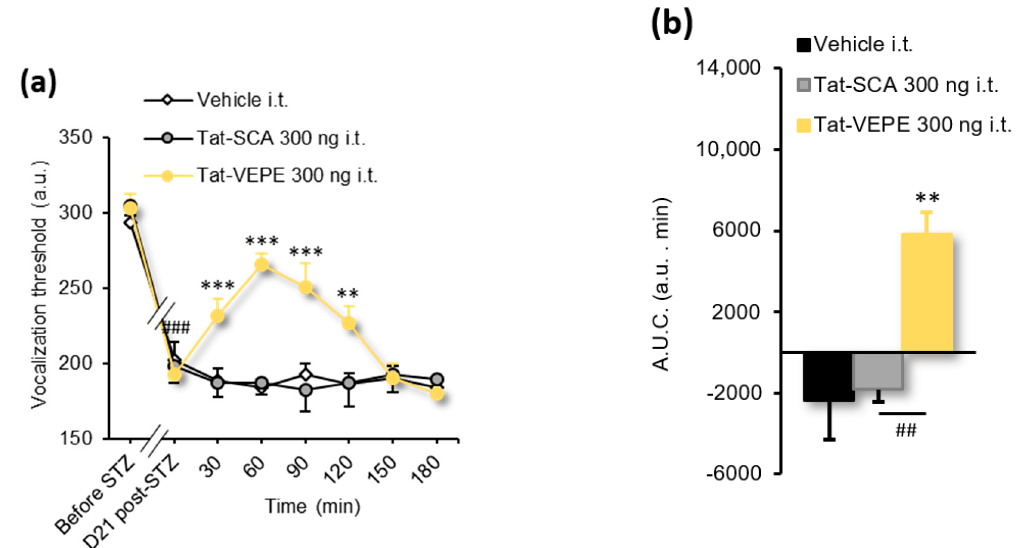
Commented [M4]: Figure 4(b) revised.